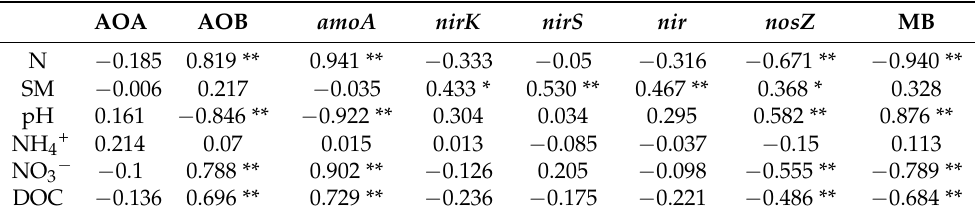
Table 1. Spearman’s correlation coefficients for the relationships between the nitrifier and denitrifier abundances and the soil physical and chemical